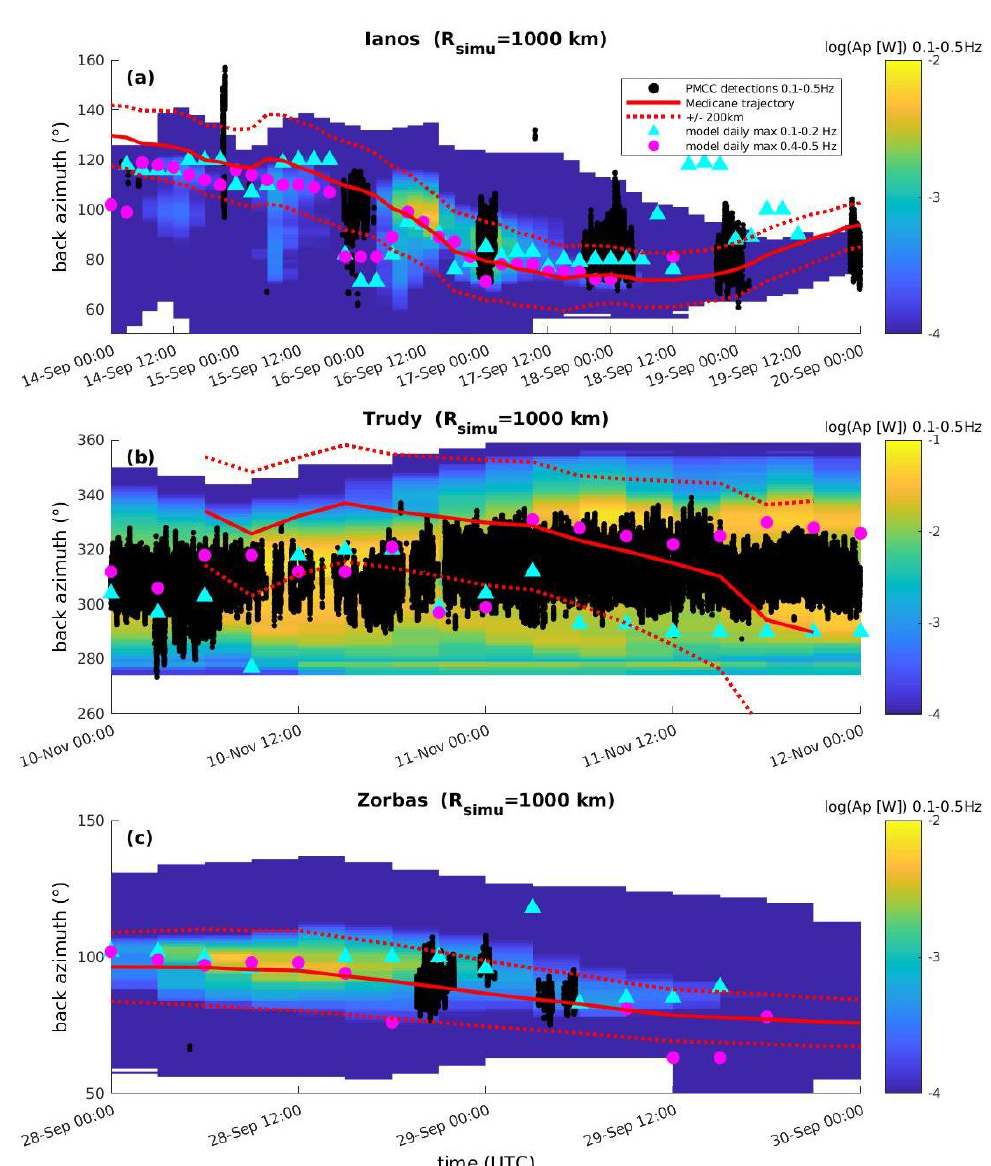
Figure 18. Simulation of infrasound detections at IS48 in the form of the acoustic directional spectrum (acoustic power in W as a function of back azimuth) in the 0.1–0.5 Hz band shown with the colormap for sources within 1000 km of IS48, for Ianos ( a ), Trudy ( b ), and Zorbas ( c ); Black dots are the PMCC detections in the 0.1–0.5 Hz band. Cyan triangles and purple circles are the daily maxima of the acoustic directional spectrum in the 0.1–0.2 Hz band and the 0.4–0.5 Hz band, respectively. The red solid line marks the medicane eye trajectory, while the dashed lines correspond to the eye trajectory +/− 200 km.